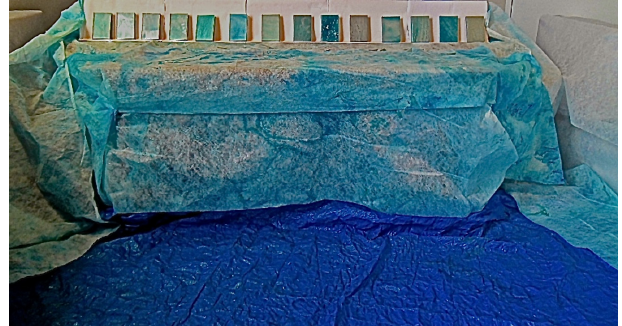
Figure 4. Glas Journal installation, Maritime Museum of Ireland, 2015. © Silvia Loeffler, Glas Journal,